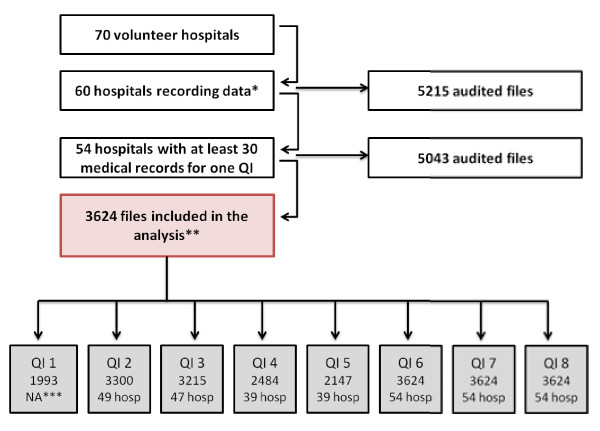
Flow-chart of hospital and medical record numbers. * Reasons for drop-outs: heavy workload (n = 5), unavailable data (n = 3), no response (n = 2). ** Reasons for exclusions: non-infiltrating or non-inflammatory breast cancer (mainly carcinoma in situ) (n = 414, 28 %), prior treatment for breast cancer (n = 597, 40 %), neo-adjuvant chemotherapy (n = 310, 21 %), bilateral breast cancer (n = 125, 8 %), and unavailable records (n = 41, 3 %). *** NA: not included in analysis as wording ambiguous according to results of feasibility test